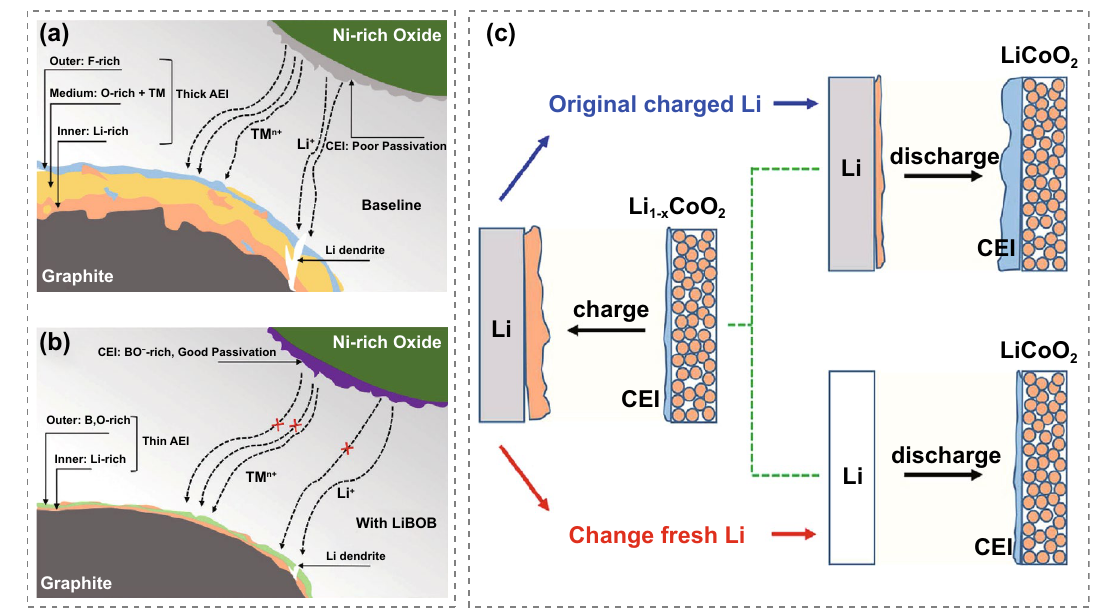
Fig. 2 Schematic illustration of the interaction between CEI and SEI caused by transition metal crossover with a baseline electrolyte and b LiBOB-added electrolyte. Copyright from Ref. [48]. c Li anode in LiCoO 2 /Li battery after the first charge (4.6 V) was replaced by fresh Li to investigate the interaction between CEI and SEI. Copyright from Ref.